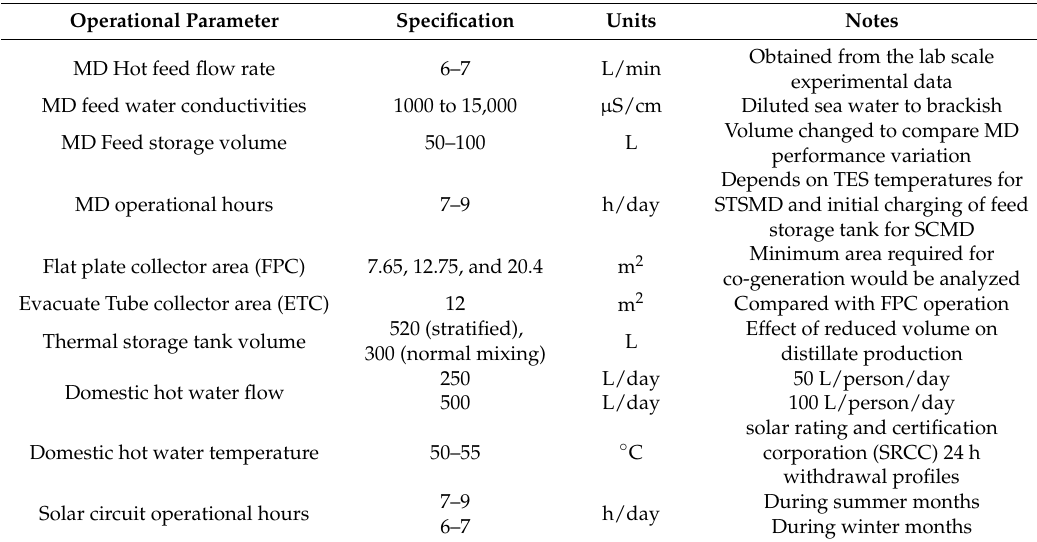
Table 2. Operational conditions used for testing co-generation